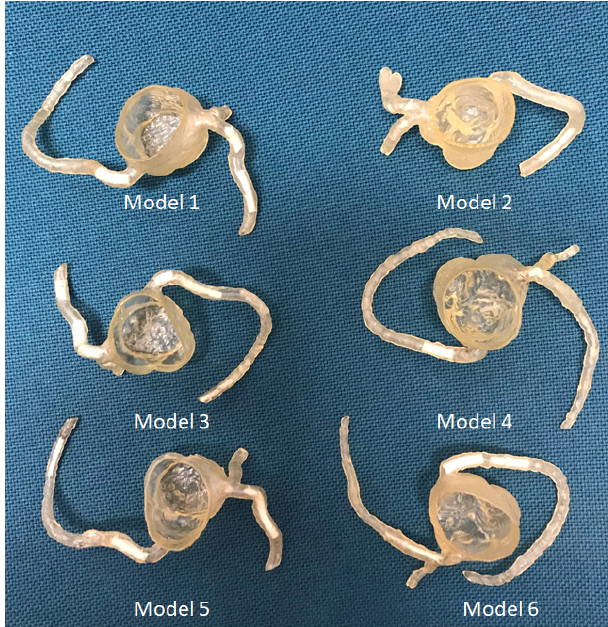
Figure 12. The 3D-printed coronary artery models with simulated calcified plaques were inserted into the coronary artery branches. Reprinted with permission under the open access from Sun et al. [83].